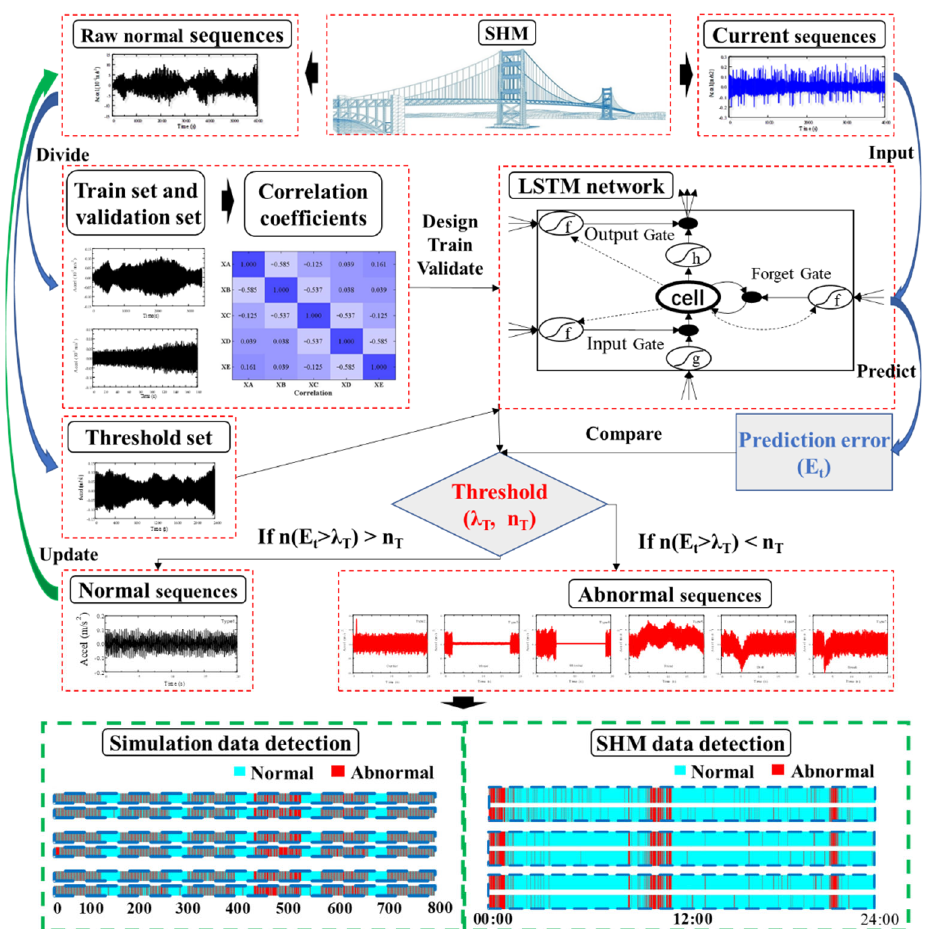
Figure 1. The framework of the proposed method.